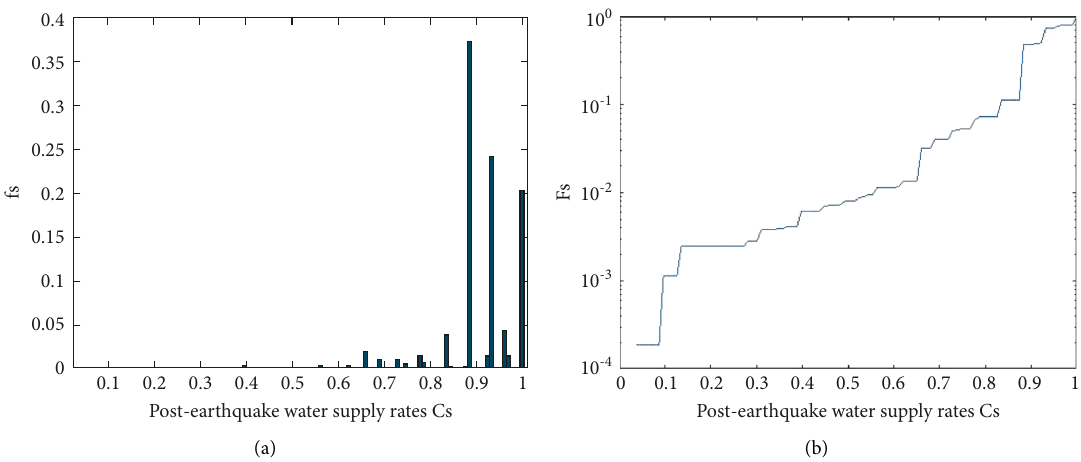
Figure 7: Post-earthquake water supply rate (steel pipe) with intermediate liquefaction of intensity IX.